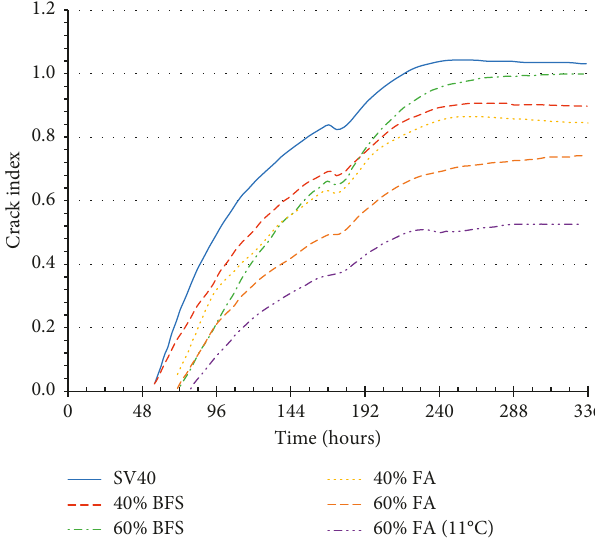
Figure 13: Crack index at the outer wall for different